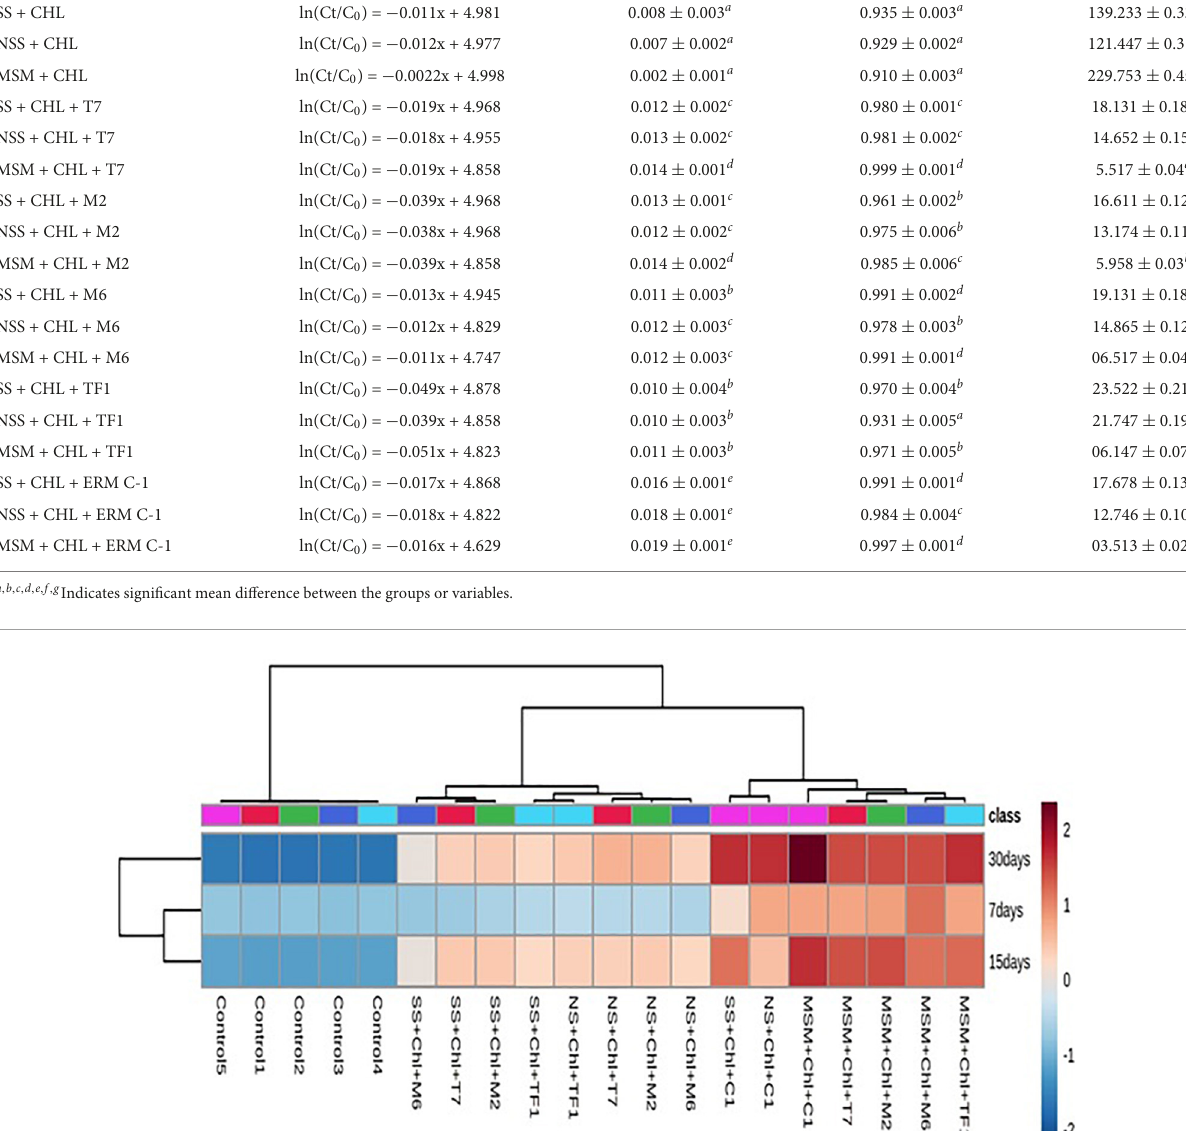
(M2), and Klebsiella pneumoniae (M6), and one fungal